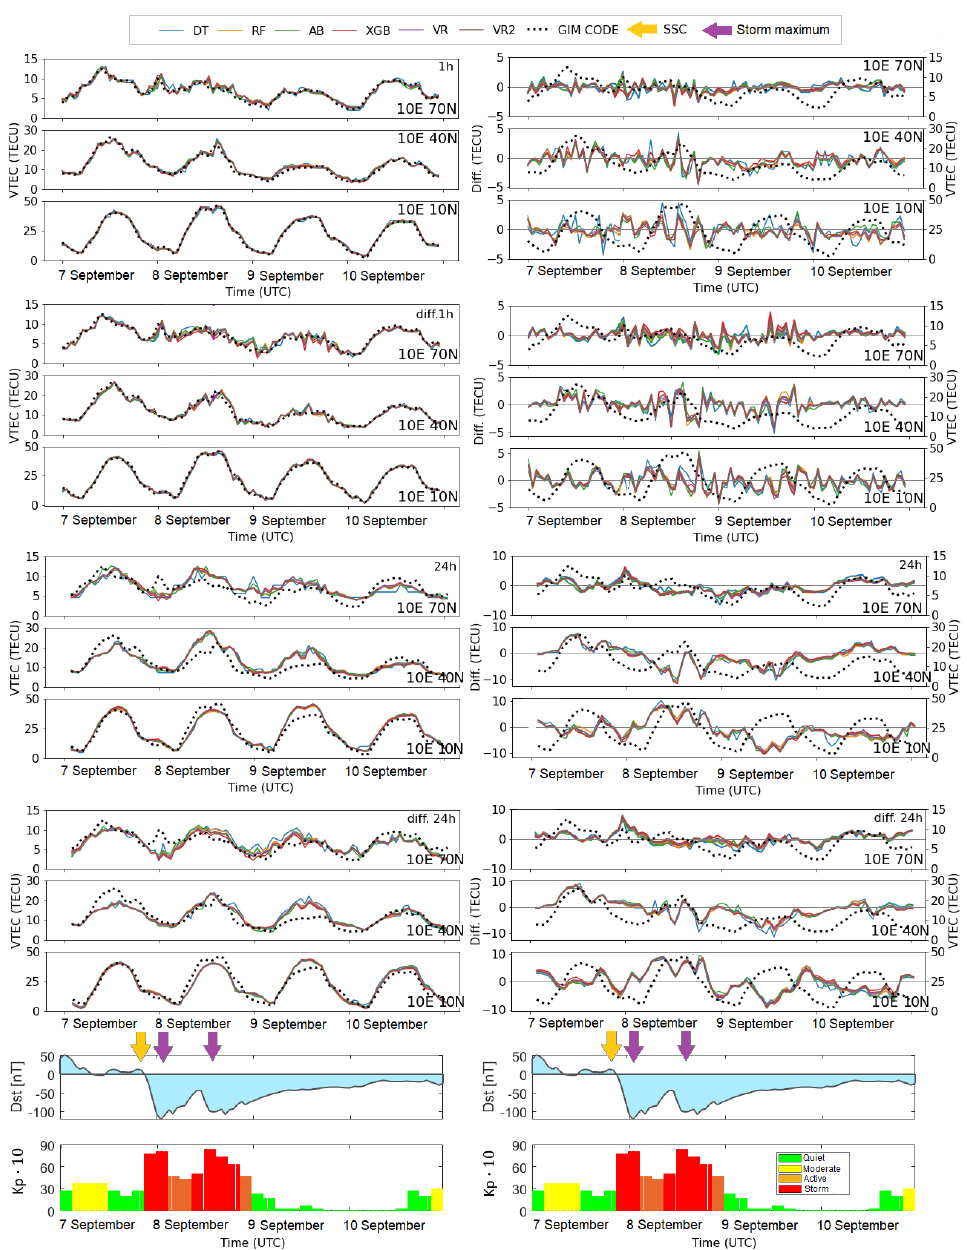
Figure 16. Left : VTEC values from machine learning models and ground truth VTEC from GIM CODE for the severe geomagnetic storm (7–11 September 2017). Right : Differences between VTEC from machine learning models and GIM CODE VTEC. From top to bottom: 1 h forecast with non-differenced data, 1 h forecast with differenced data, 24 h forecast with non-differenced data, 24 h forecast with differenced data, Dst index, and Kp index · 10. The yellow arrow denotes the sudden storm commencement (SSC) time, while the purple arrows point to two Dst minima, which correspond to the maximum phase of the geomagnetic